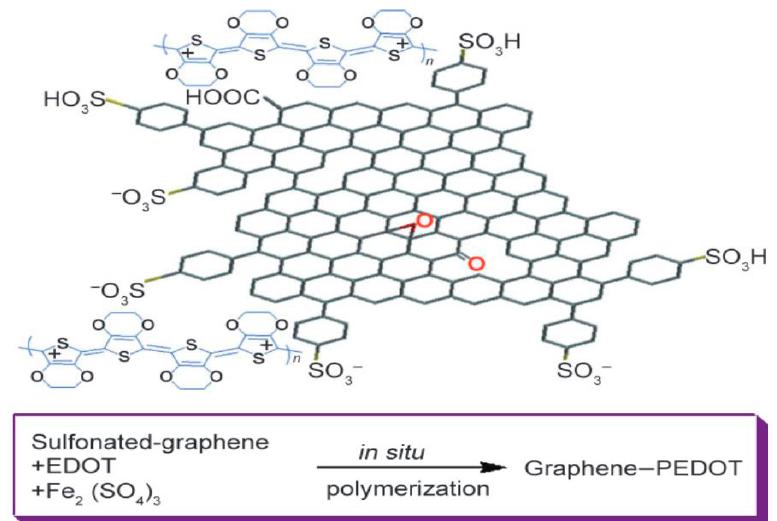
Figure 2. Schematic representation of sulfonated graphene (SG)/poly(3,4-ethylenedioxythiophene):poly(styrenesulfonate) (PEDOT) nanocomposite and its synthesis-reaction conditions. Reprinted from Ref. [44].